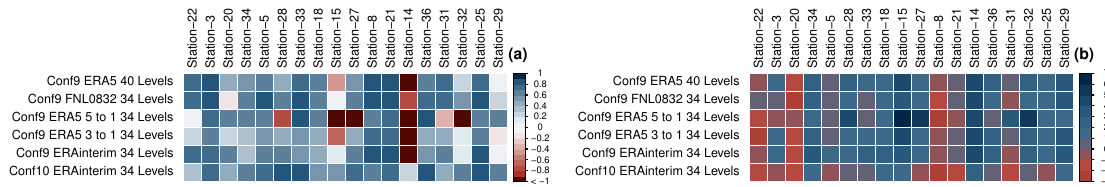
Figure 9. Matrix of statistics for mean temperature for different forcing data: ( a ) NSE, and ( b )